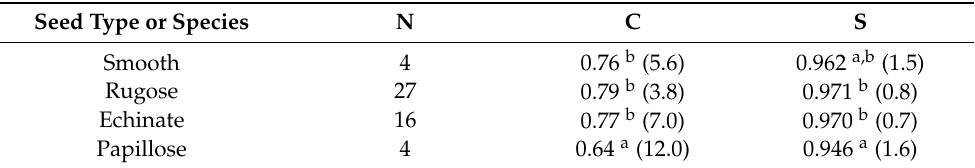
Table 4. Results of Kruskal–Wallis post hoc tests for the comparison between the average silhouettes of the lateral views in the four morphological seed groups (smooth, rugose, echinate, and papillose). Mean values and coefficient of variation (given in parentheses) are indicated for aspect ratio (AR), circularity (C), roundness (R) and solidity (S). Values marked with the same superscript letter in each column correspond to populations that do not differ significantly at p < 0.05 (Campbell and Skillings test). N indicates the number of average silhouettes